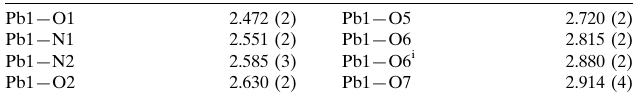
Selected bond lengths (A˚ ).